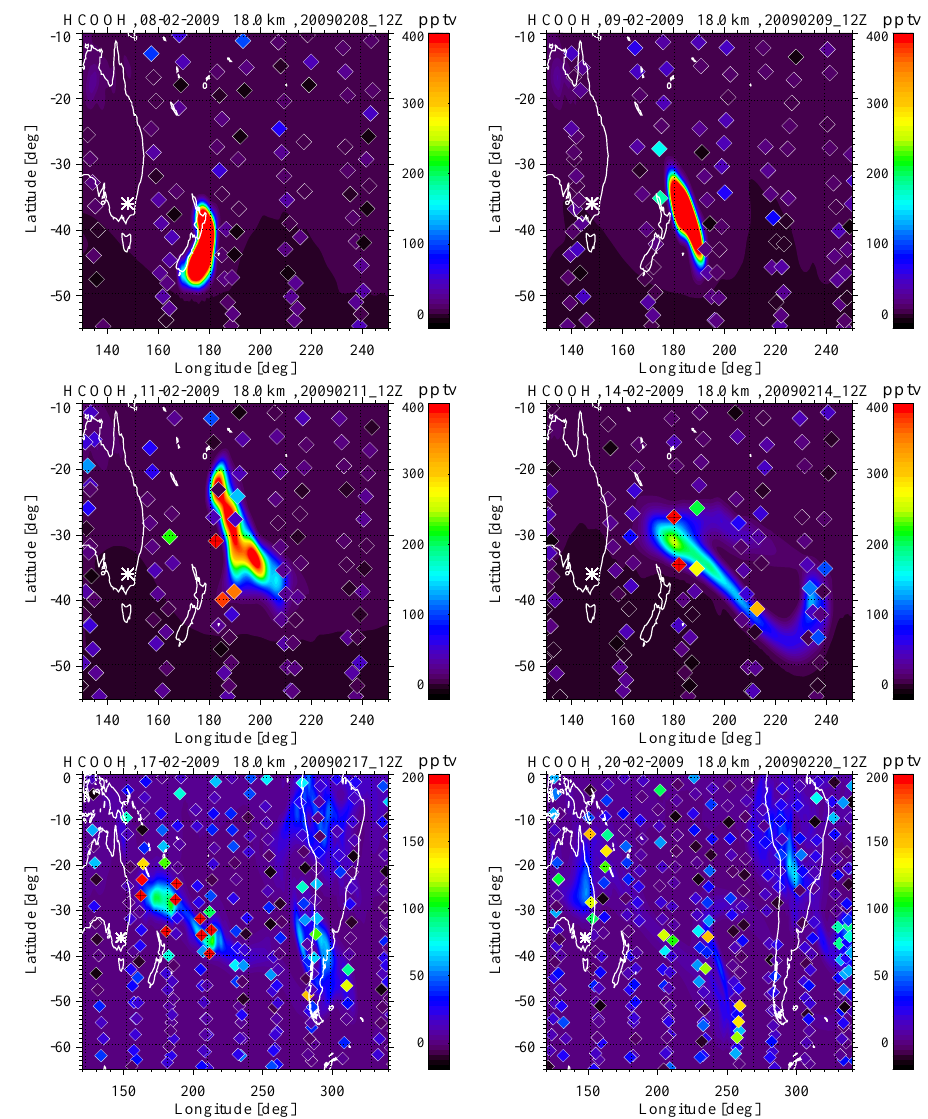
Fig. 8. Measured and modelled HCOOH at 18km altitude. Model distributions are smoothed vertically and along-track to MIPAS resolution. Note the different map section and colour scale for the bottom panel. For more details see Fig.